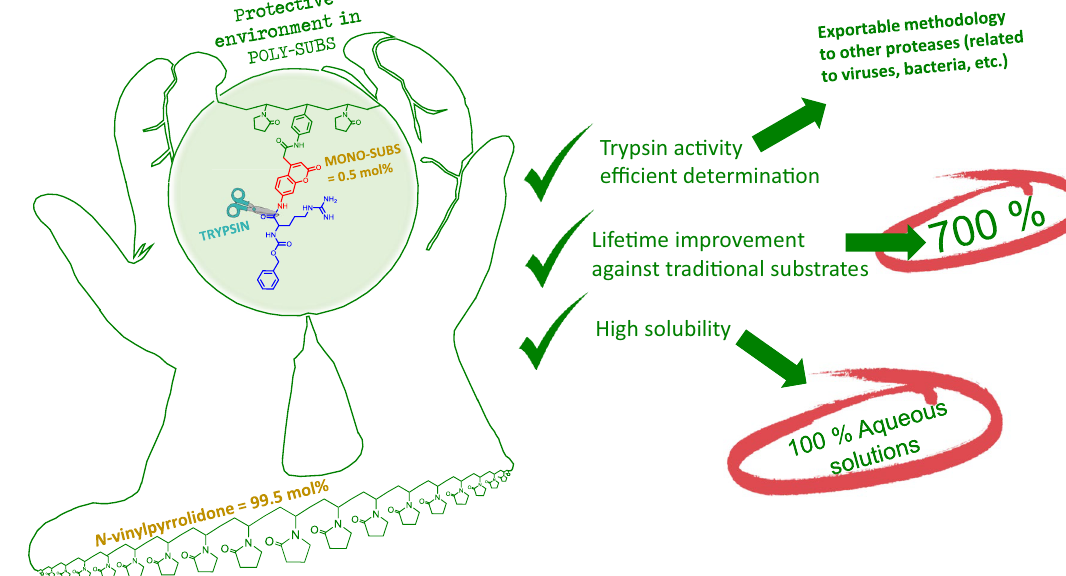
Figure 1. Graphical abstract of the study depicting the general idea, including the main advantages of the